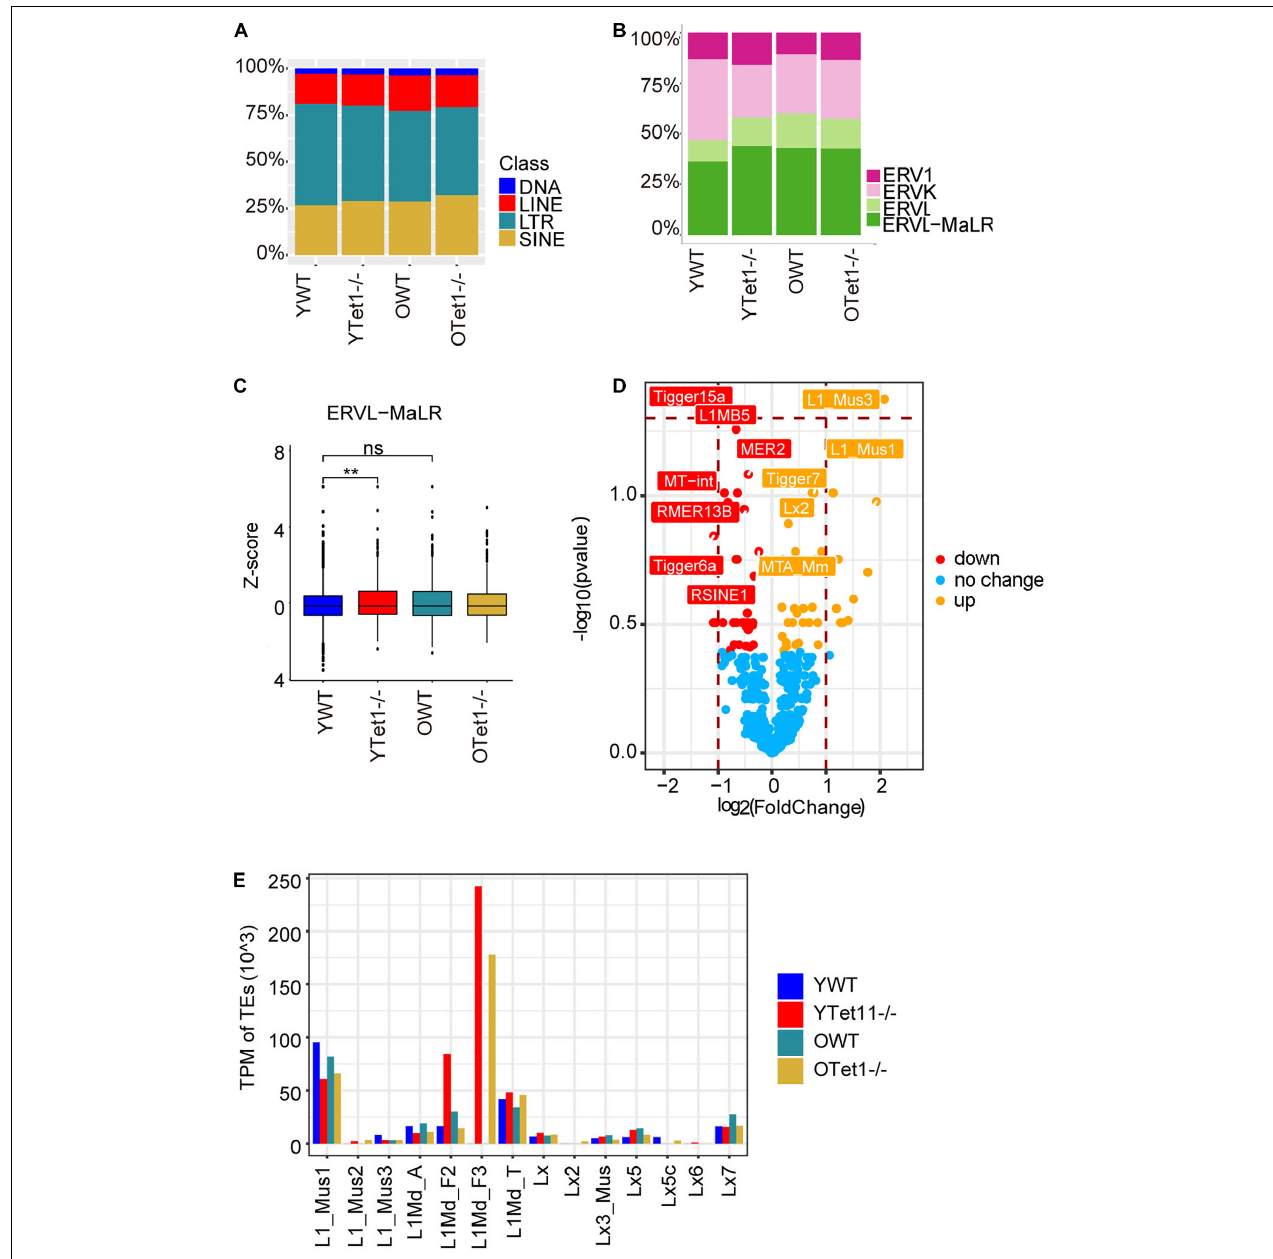
FIGURE 5 | Expression of transposon elements (TEs) of Tet1 − / − and WT oocytes. (A) Barplot showing the proportion of TEs in young Tet1 − / − , WT, old Tet1 − / − , and WT oocytes. (B) Barplot displaying the proportion of ERVs in young Tet1 − / − , WT, old Tet1 − / − , and WT oocytes. (C) Z -score showing expression of ERVL-MaLR between young Tet1 − / − and WT oocytes. Data are shown as mean ± SEM. ** P < 0.01. (D) Volcano showing the differential TEs between young Tet1 − / − and WT oocytes. Orange represented upregulated TEs compared with young WT oocytes. (E) Expression of Full-length L1 family in young Tet1 − / − and WT oocytes, and old Tet1 − / − and WT